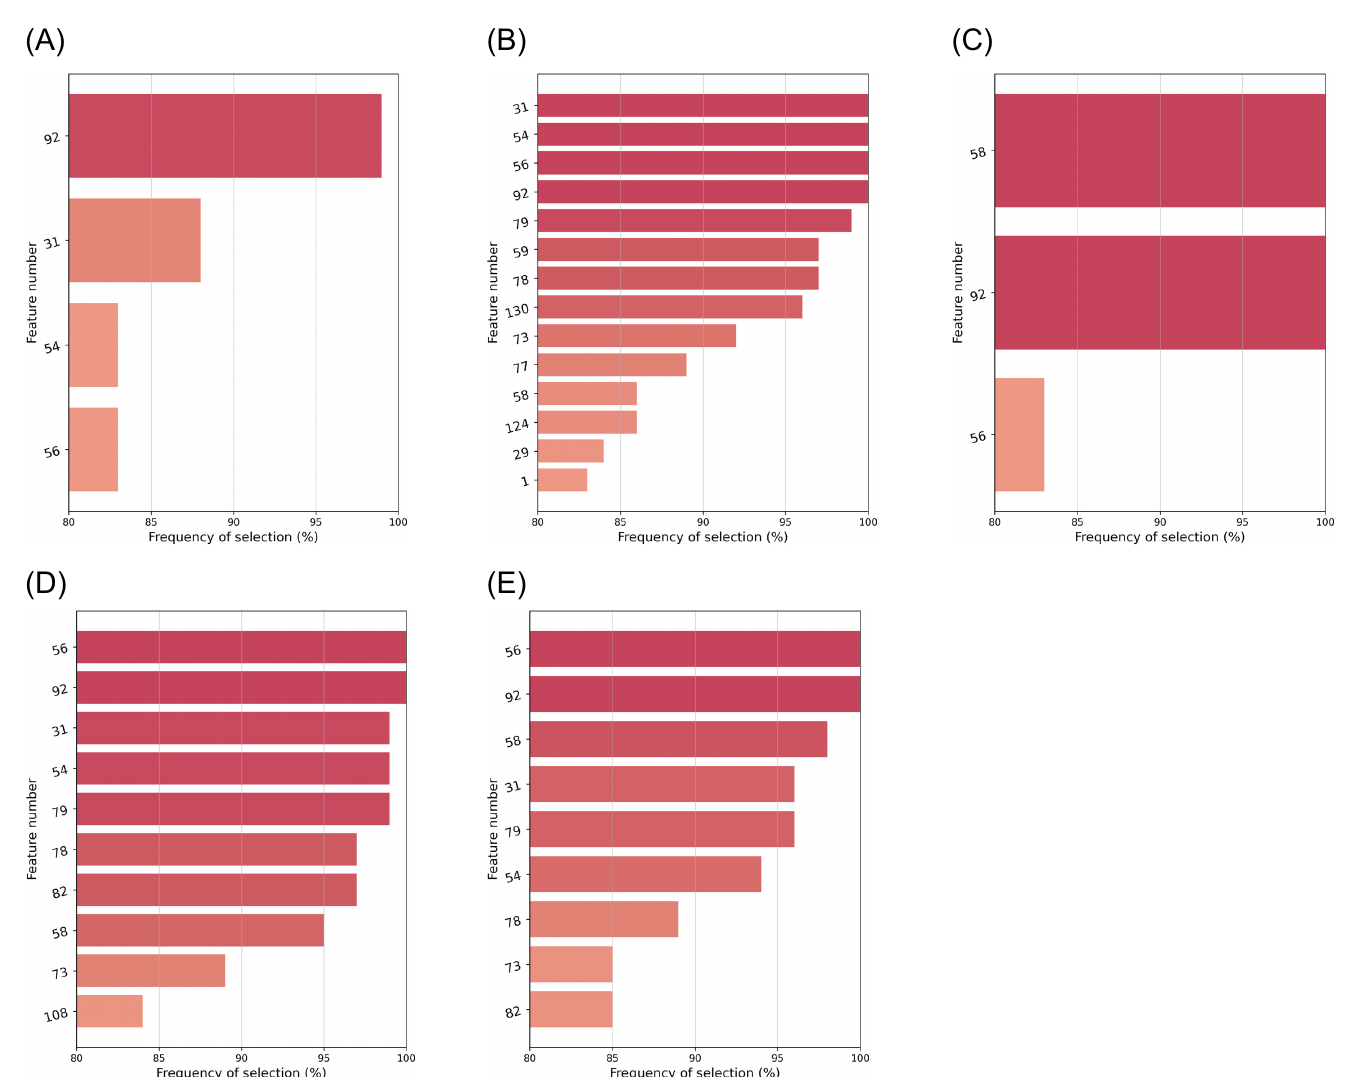
Fig 5. Features selected in ⩾ 80% cases by the stable RFE wrappers ( a,b ) and embeddeds ( c–e ): All of them with the k nn imputer. ( a ) RFE: n FS = 5. ( b ) RFE: n FS = 20. ( c ) L 1 -LR: C = 0.005. ( d ) Lasso: α = 0.050. ( e ) Lasso: α = 0.075.